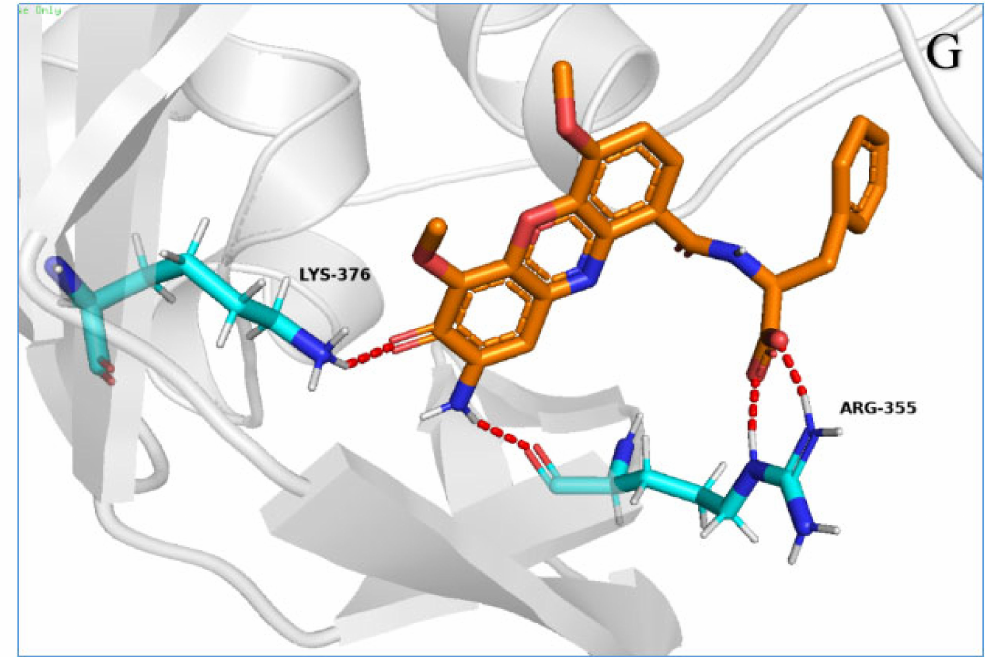
Figure 6. Representative structures of VX-787 or our active compounds with the largest population in the MD simulation. Shown are representative structures of ( A ) VX-787 with PB2; ( B ) Str1614 with PB2; ( C ) Str1916 with PB2; ( D ) Str3107 with PB2; ( E ) Str5776with PB2; ( F ) Str6318 with PB2; and ( G ) Str7374 with